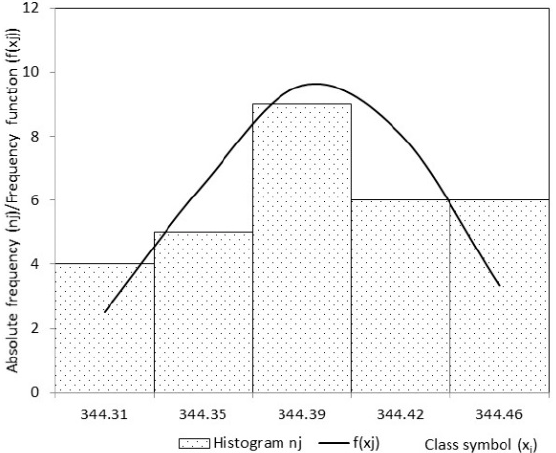
Figure 20. Histogram and the frequency function for the length parameter, third day.